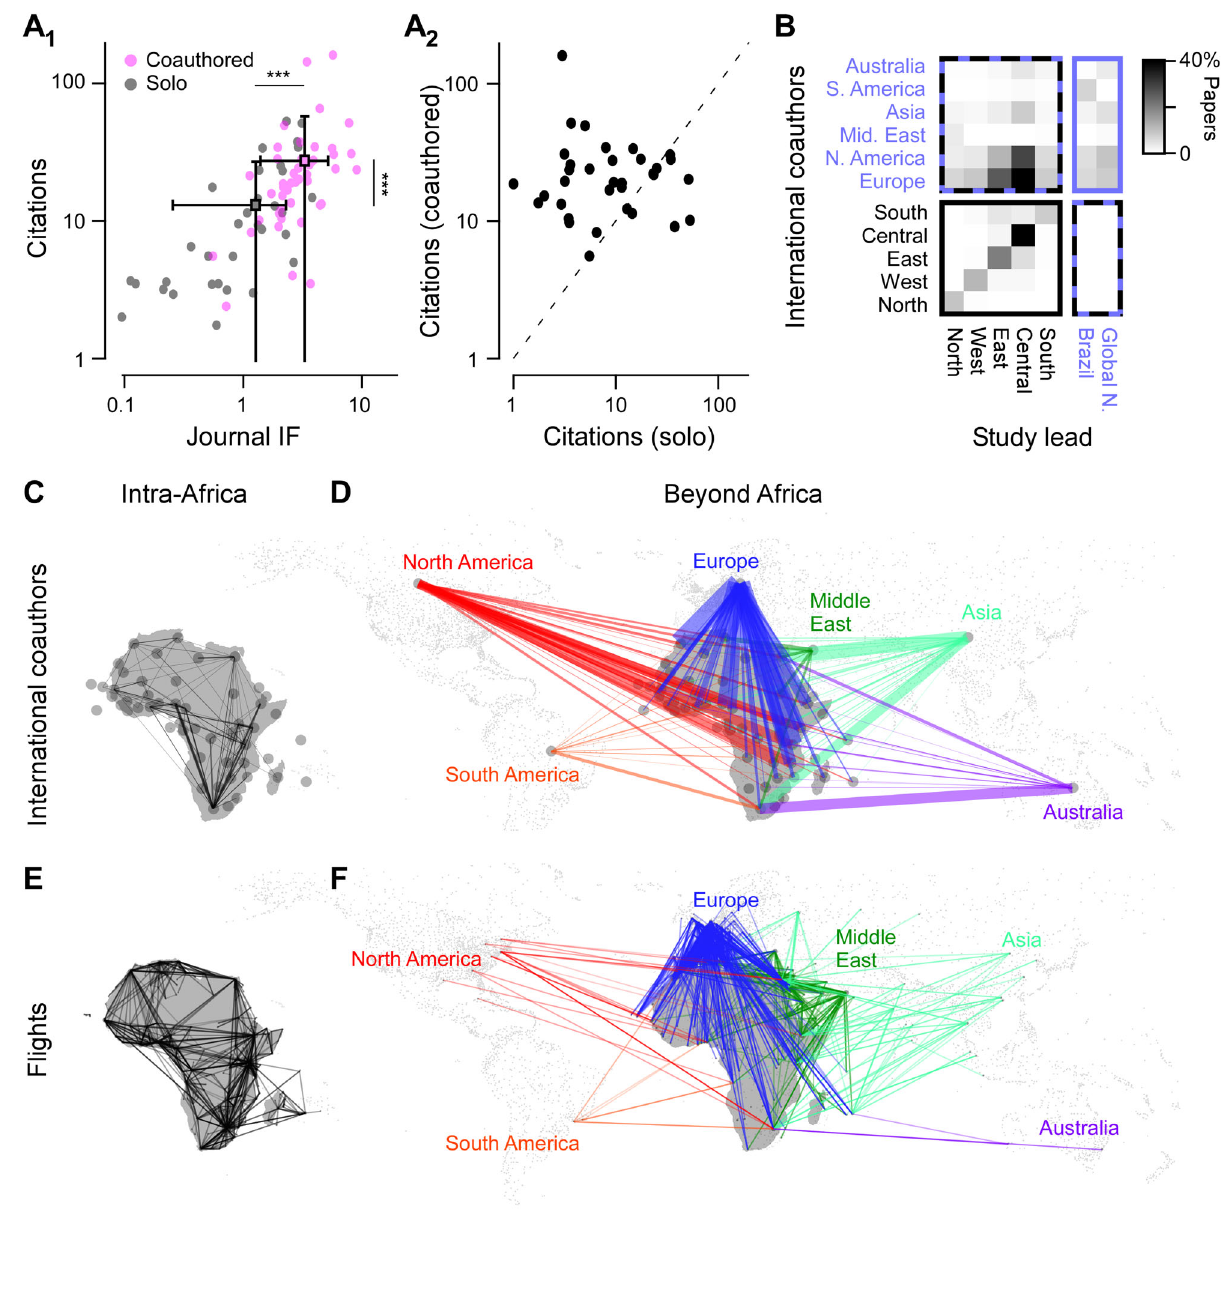
Fig. 3 Co-authorships. A 1 Citations plotted against the journal impact factor (IF) for each African country, divided into publications without (grey, ‘ solo ’ ) and with international co-authors (pink, ‘ coauthored. ’ ). The latter included both within-Africa international co-authors as well as co-authorships beyond Africa ’ s borders. Square-markers and errors denote each population ’ s mean and s.d. Both citations and IFs were signi fi cantly higher for internationally co-authored papers (Wilcoxon Rank Sum, 1-tailed, *** p <0.001, full p values: 7.7×10 − 15 and 1.1×10 − 12 for citations and IF, respectively; n = 45 countries in both cases). A 2 The same citation data as ( A 1 ) plotted pairwise for with ( y -axis) and without international co-authors ( x -axis), highlighting the substantial positive in fl uence of international co-authors. Dotted line indicates parity. B Co-authorship matrix between African regions and the rest of the world, with darker colours indicating a higher preponderance of international co-authorships. C , D Intra-African ( C ) and Beyond-African ( D ) co-author links organised by African country and major geopolitical regions beyond Africa, as indicated. The thickness of lines illustrates the total number of internationally co-authored papers, while colourings in ( D ) illustrate the co-authorships with partner beyond Africa. E , F as ( C , D ), respectively, but for the existence of international fl ight routes based on data from OpenFlights.org. Each route is illustrated with a single line of consistent opacity and thickness. Source data are provided as a Source Data fi